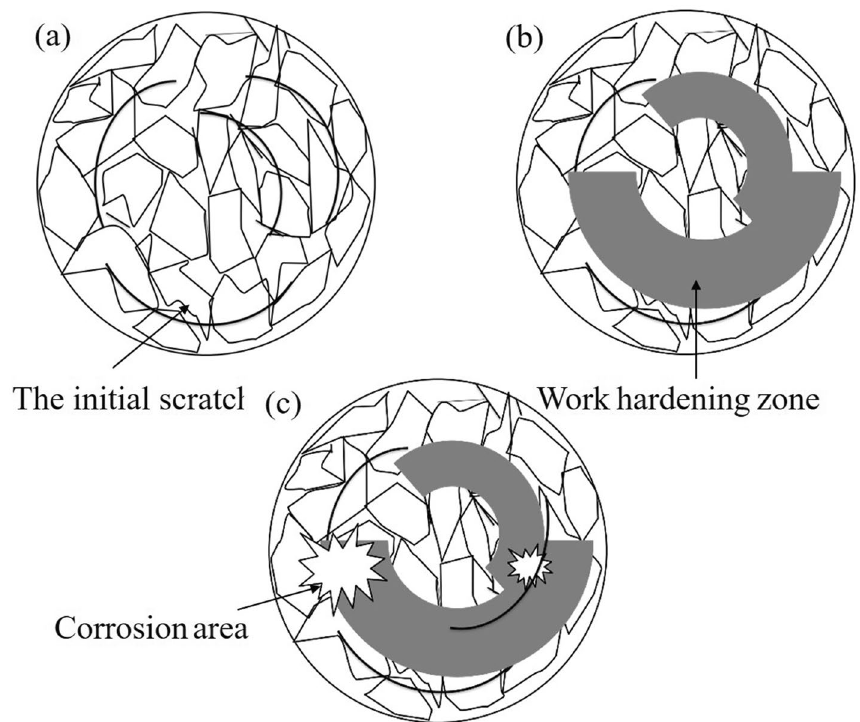
Figure 7. The mechanism diagram of frictional